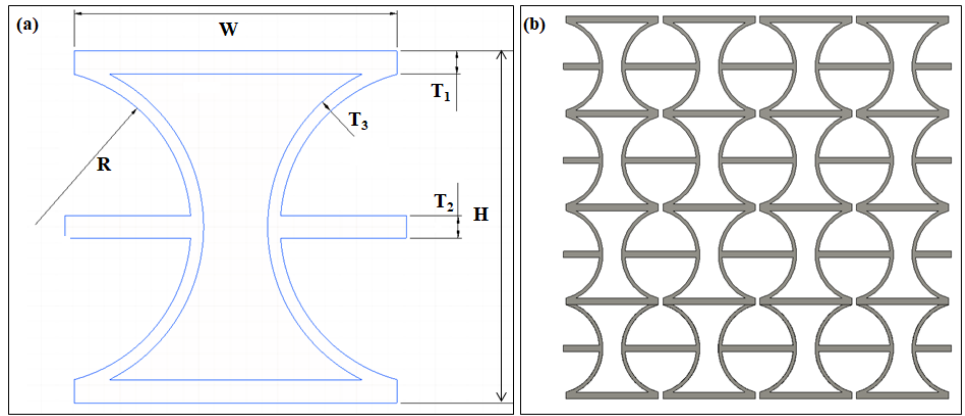
Figure 2. ( a ) Geometry profile of a CS-based unit and ( b ) the metamaterial structure.